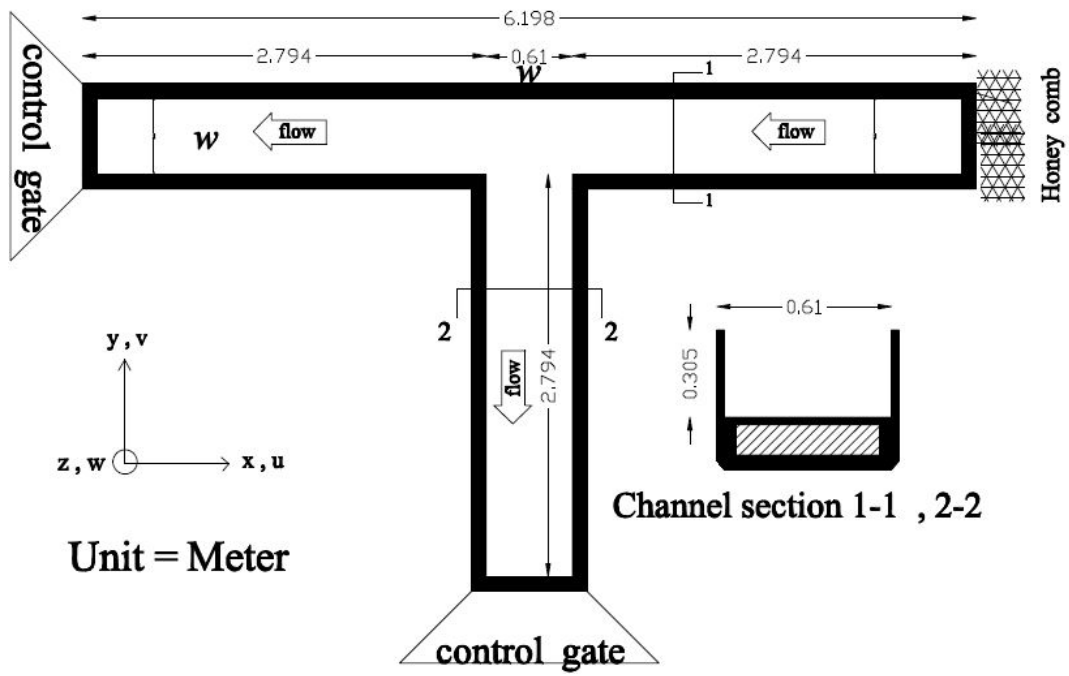
Figure 1. The plan of the experimental channel used in current research.